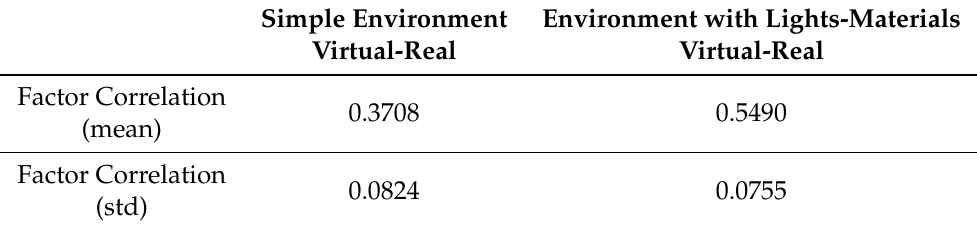
Table 1. Correlation between real-world and virtual